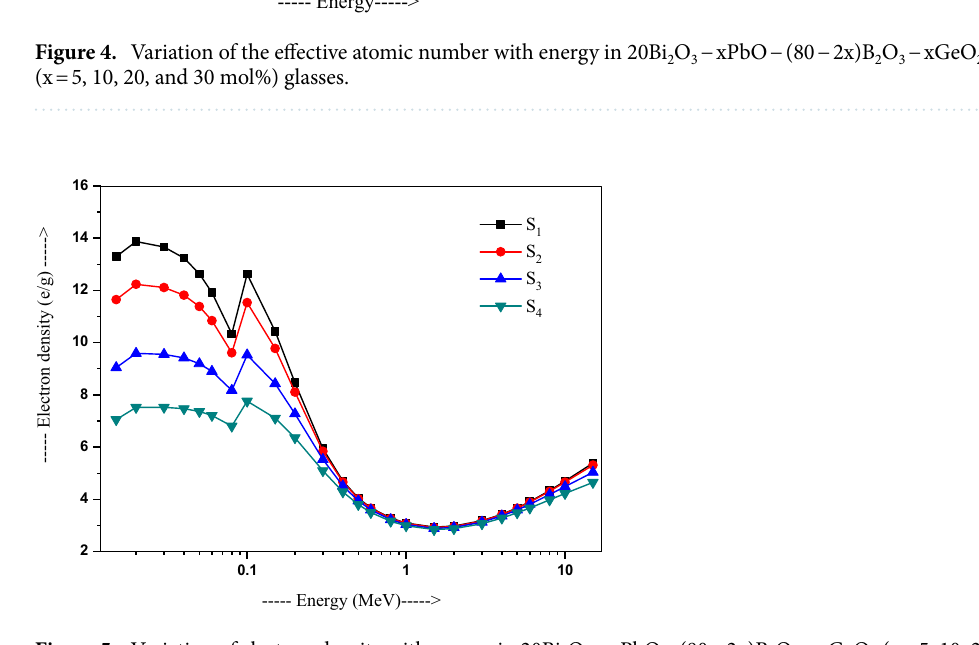
Figure 5. Variation of electron density with energy in 20Bi 2 O 3 − xPbO − (80 − 2x)B 2 O 3 − xGeO 2 (x = 5, 10, 20, and 30 mol%)